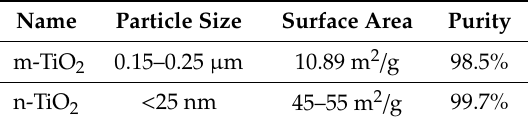
Table 2. Physical properties of anatase TiO 2